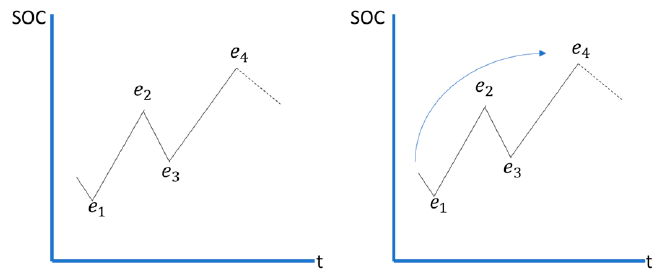
Figure 5. The cycle counting principle using the rainflow algorithm. It should be noted from this that the R-factor is susceptible to the discharge/charge routines applied. The likelihood of individual peaks being characterized by a better R- factor than a continuous train of peaks is high. That caters for a smaller battery with lower investments but also a higher frequency of charge/discharge. A smaller and more affordable battery might thus be subjected to a higher frequency of deep cycles and be exposed to an accelerated life-loss that would demand a shorter payback period for the investment. A bigger battery can sustain a duration of multiple peaks in a row without recharging, until the state of charge has reached the minimum level. Hence, the frequency of deep discharge/charge cycles will be lower, which could extend the battery life and thus the duration of the payback